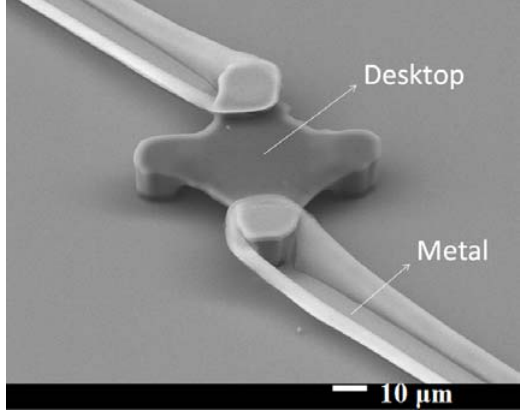
Figure 8. SEM picture of SU-8 photoresist platform structure with metal